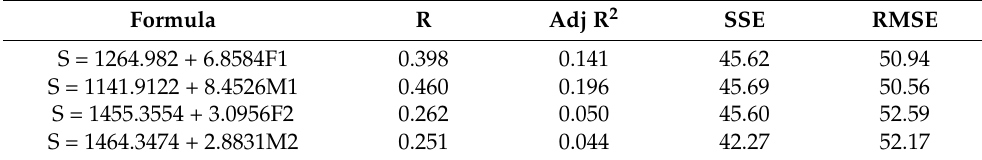
Table 3. Regression formulae for males ( n = 51) with its correlation coefficient (R), adjusted determi- nation coefficient (Adj R 2 ), standard error of estimate (SEE) and root mean square error (RMSE). Formula R Adj R 2 SSE RMSE S = 1264.982 + 6.8584F1 0.398